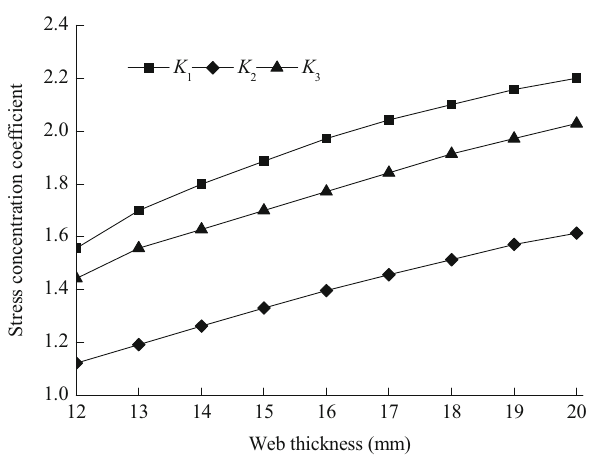
Fig. 9 Relationship between SCC and the cope-hole radius